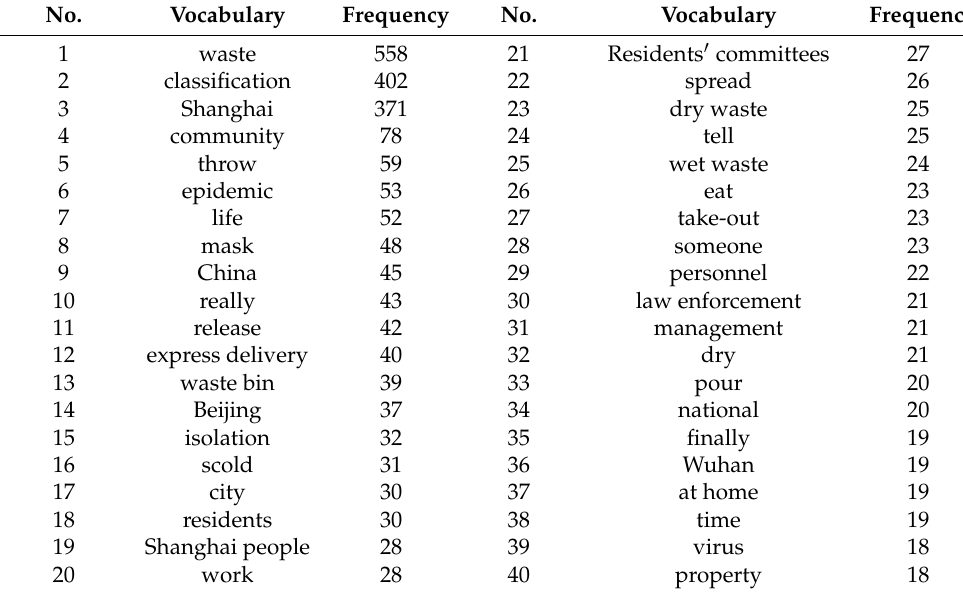
Figure 2. Percentage of negative posts from July 2019 to December 2020. Table 2. High frequency vocabularies, February–March 2020.